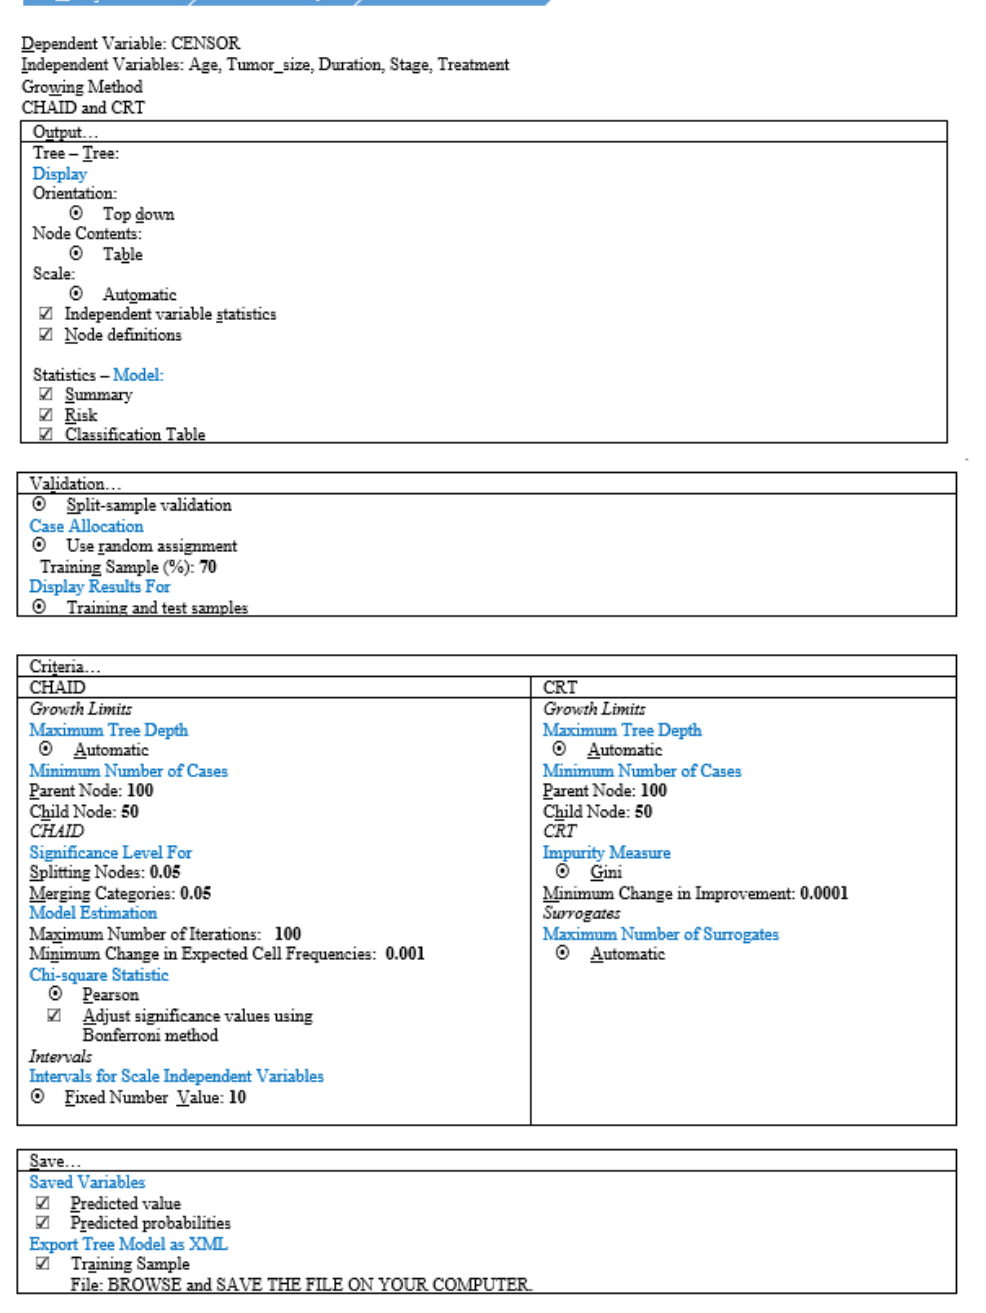
Figure 12. SPSS set up for Decision Tree